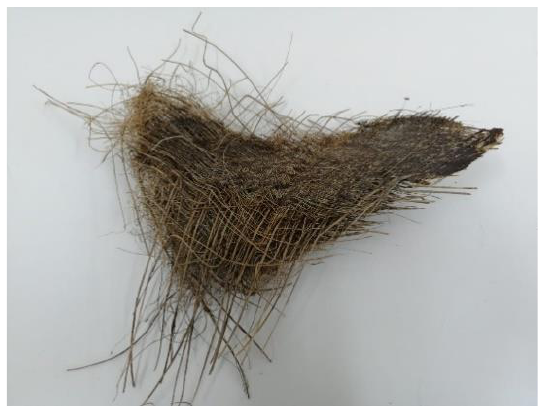
Figure 3. Date Palm Mesh Fibers.